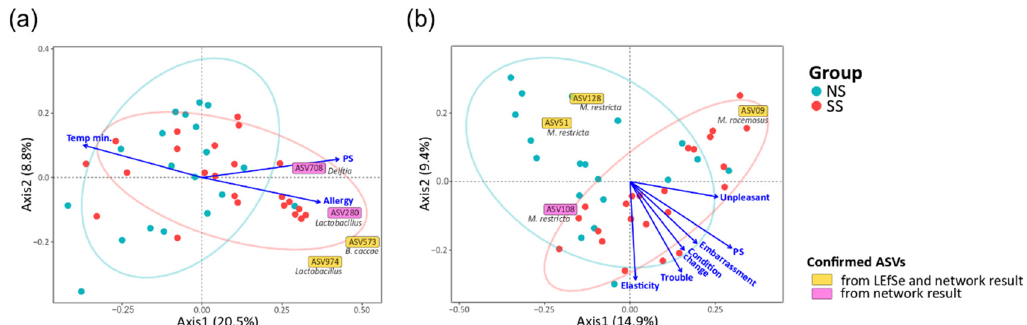
Figure 5. Correlation of quantitative factors with the structures of the skin ( a ) microbiome and ( b ) mycobiome. The arrows indicated the increasing directions of the quantitative gradients of the factors. Each text box represents the increasing direction of the corresponding ASV from the origin. The statistics were calculated using the envfit function of vegan in R. (Allergy, the experience of skin allergy; Temp min., minimum temperature; PS, perceived skin sensitivity; Embarrassment, embarrassment due to skin problems; Condition change, recognition of any changes in skin condition; Trouble, recognizing trouble when using cosmetics; Elasticity, skin touch elasticity; Unpleasant, unpleasant sensation on the